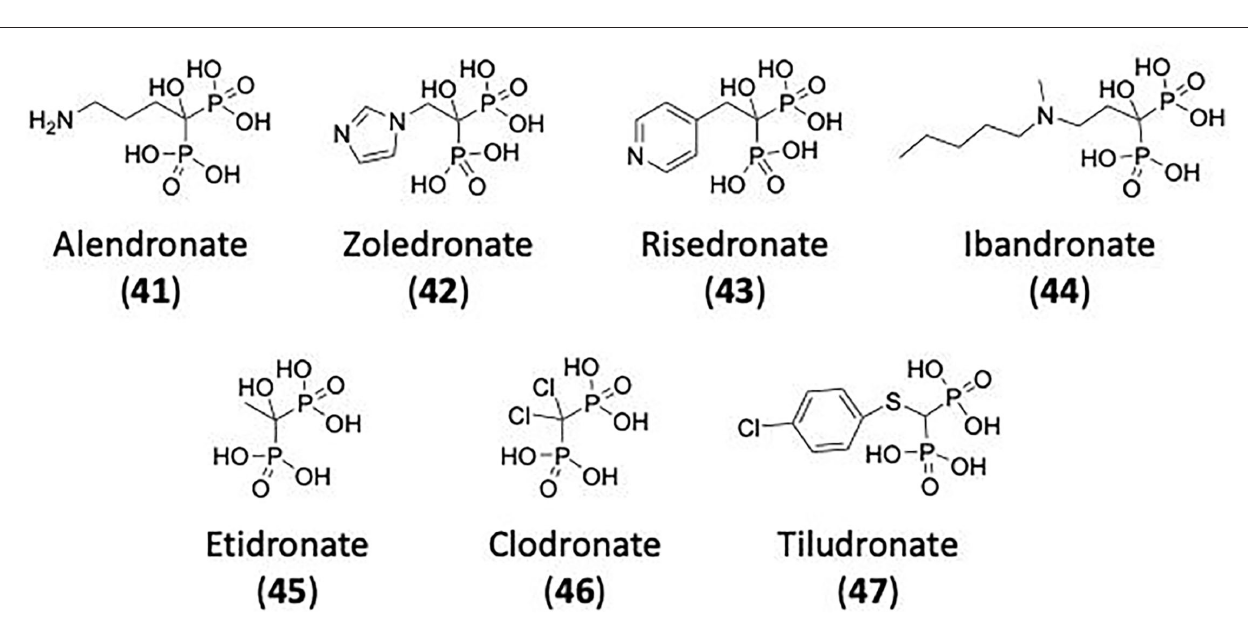
FIGURE 13 | Bisphosphonates (BPs) as dynamin inhibitors. Nitrogen containing BPs (N-BPs); alendronate ( 41 ), zoledronate ( 42 ), risedronate ( 43 ), and ibandronate ( 44 ) and Non-nitrogen containing BPs (NN-BPs); etidronate ( 45 ), clodronate ( 46 ) and tiludronate ( 47 ). Alendronate ( 41 ), zoledronate ( 42 ), and etidronate ( 45 ) are believed to inhibited CME via dynamin